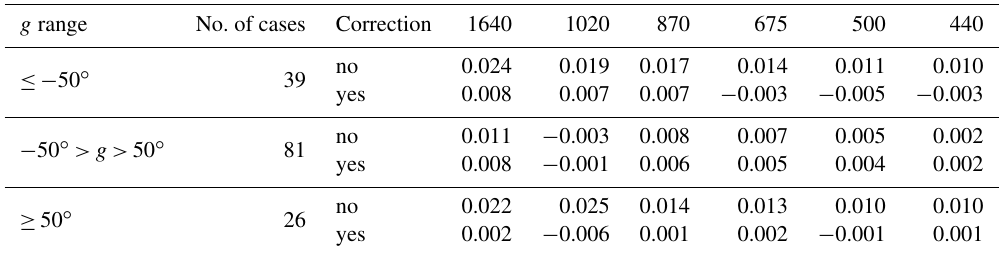
Table 2. Averaged AOD differences between CE318-AERONET daytime and CE318-T nighttime data ( (cid:49) AOD trans ) during sunset–moonrise and moonset–sunrise in three ranges of the Moon’s phase angles ( g ) with and without δ g,θ correction. g range No. of